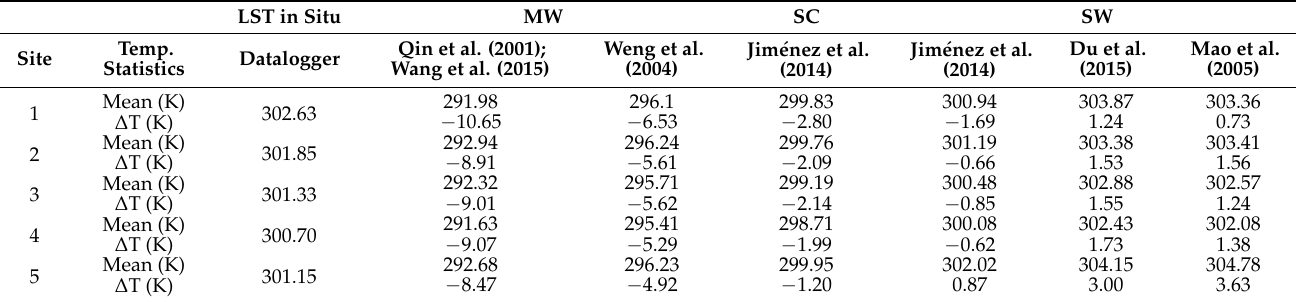
Table 7 offers the calculated statistical data of the LST for each algorithm and for each measurement point of the datalogger. The average LST of the urban areas was higher (299.73 K) than the LST of the suburban areas (299.10 K) and the LST of the large interior green area (298.39 K). The maximum thermal difference detected between the urban versus suburban area was 12.8 K, as compared to the difference between the urban area and the central green area, 13.15 K. Also detected was LST seasonal variability between urban areas and suburban ones. Accordingly, the average LST difference between the two zones in winter was 0.77 K, while this value reached 1.61 K in the summer. Table 7. Average values and temperature differences by points and